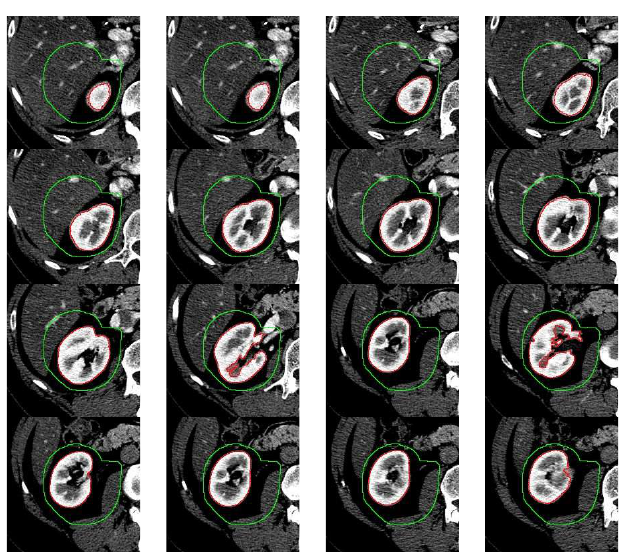
Figure 8. The image shows a visualization of selected slices. Green is the starting search area while red is the automatic kidney system.